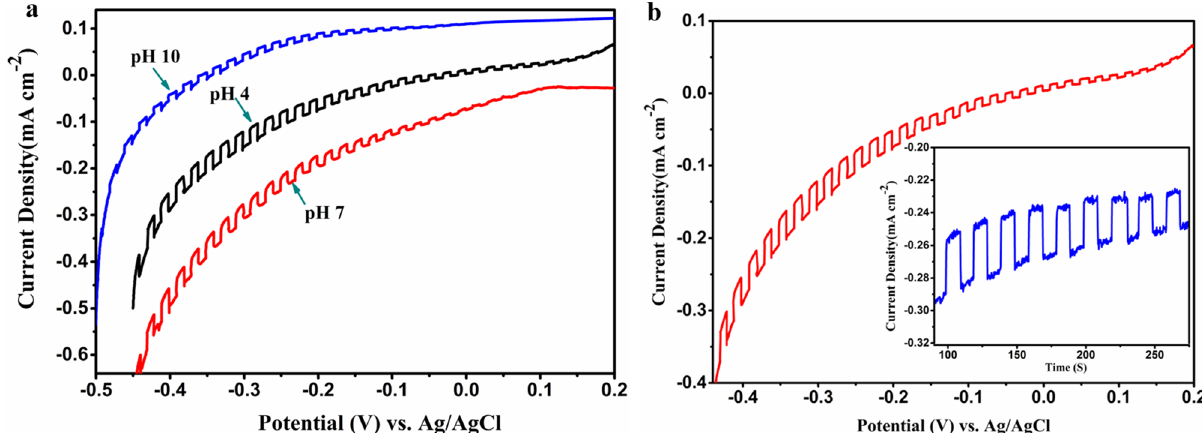
Figure 8. ( a ) Current–voltage (J–V) curve of the Cu 3 VSe 4 NSs thin film in KCl aqueous solution of various pH values; ( b ) photocurrent response of the Cu 3 VSe 4 NSs thin film in KCl aqueous solution with pH of 4 at − 425